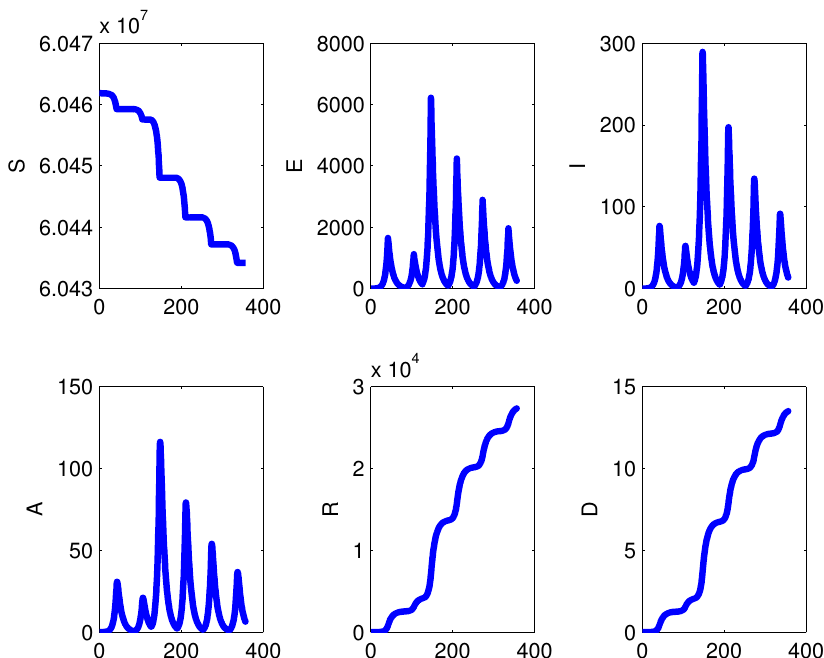
Figure 21. The population values with the lock-down policy, implemented after the first thee weeks with the reduced contact rate β I = 10 − 10 , after which β I = 10 − 7 resumes. The check for possible repeated implementation is implemented every three weeks afterwards. The simulation runs over a two year timespan for the model (1) with no demographics, i.e., Λ = d p = 0. Left to right and top to bottom, the subpopulations are: S , E , I , A , R and D , the disease-related deceased class.